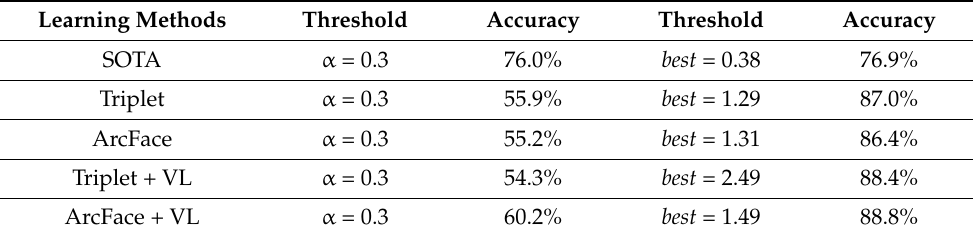
Table 3. Results of the mean of the optimum accuracy and the threshold for the learning methods in face verification.